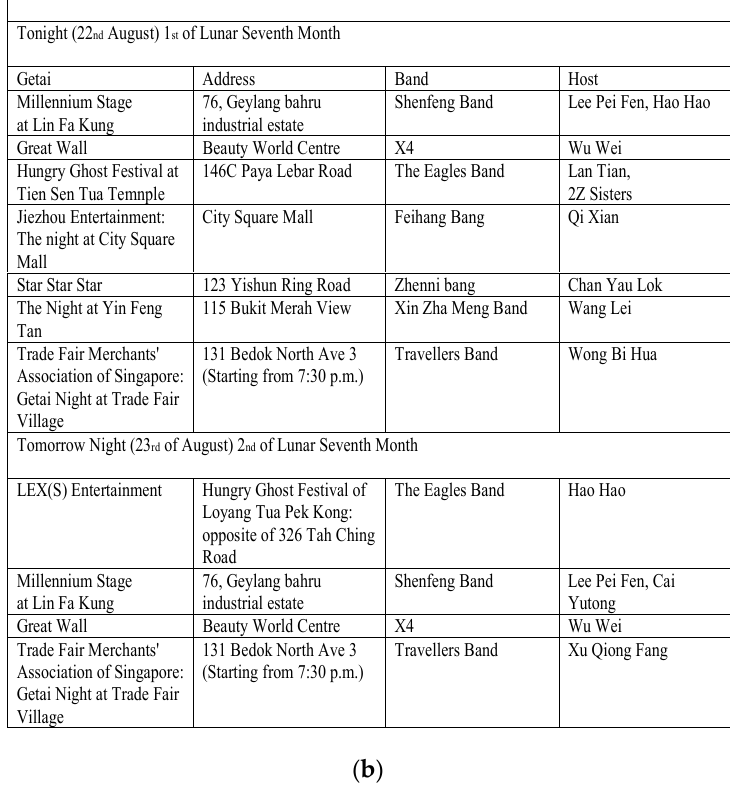
Figure 2. An Announcement of Getai Performances (Lianhe Wanbao 2017) ( a ) with English translation ( b ).